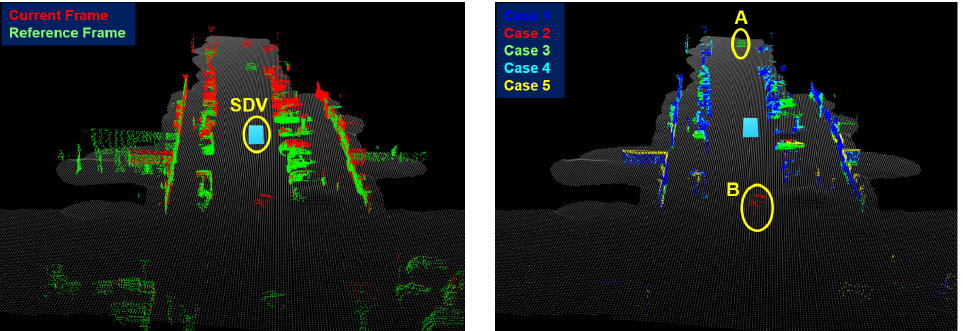
Figure 7. The image on the left shows the superposition of the current frame and reference frame (a frame in the SAF set). The image on the right shows the classification result obtained by comparing the current frame with the reference frame. It can be seen that the moving vehicle A in front of the SDV is classified as Case 3, and the vehicle B behind the SDV is classified as Case